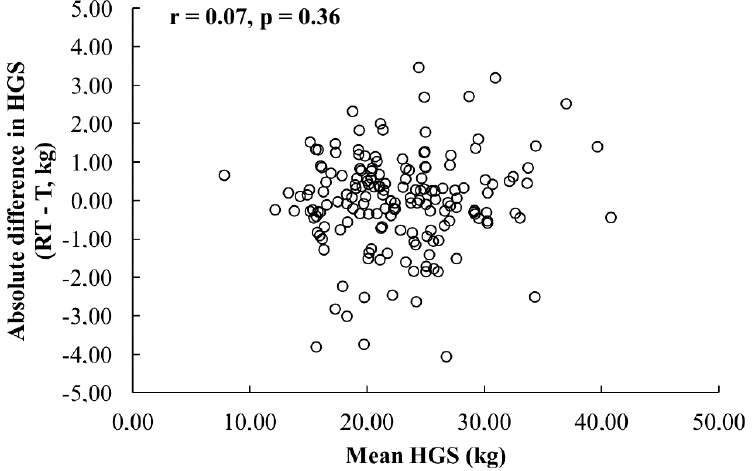
Figure 2. Pearson ’ s correlation coefficients of the absolute difference between the test and retest and Figure 2. Pearson’s correlation coe ffi cients of the absolute di ff erence between the test and retest and the mean of the test and retest for the dominant hand in 10 – 13 years age group (T — test, RT — retest). the mean of the test and retest for the dominant hand in 10–13 years age group (T—test, Table 2. The handgrip strength for children (7 – 9 years) and preadolescents (10 – 13 years) and reliability statistics for dominant hand. Values are presented as mean ± SD.